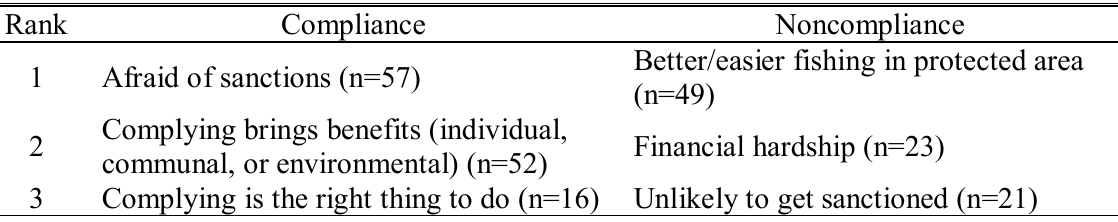
Table A2.1. Three highest-ranked factors considered by respondents to influence compliance and noncompliance. n= number of mentions by